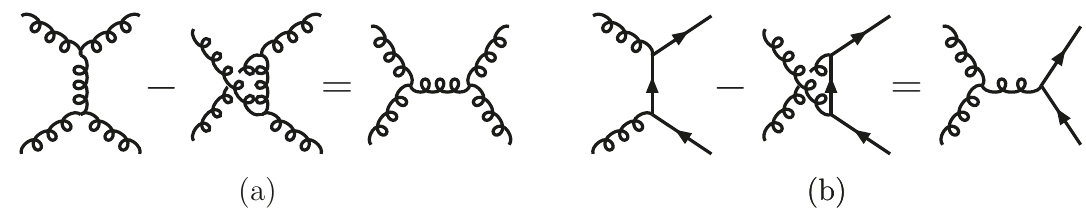
Figure 2 . Pictorial form of the basic color and kinematic Lie-algebraic relations: (a) the Jacobi relations for (cid:12)elds in the adjoint representation, and (b) the commutation relation for (cid:12)elds in a generic complex